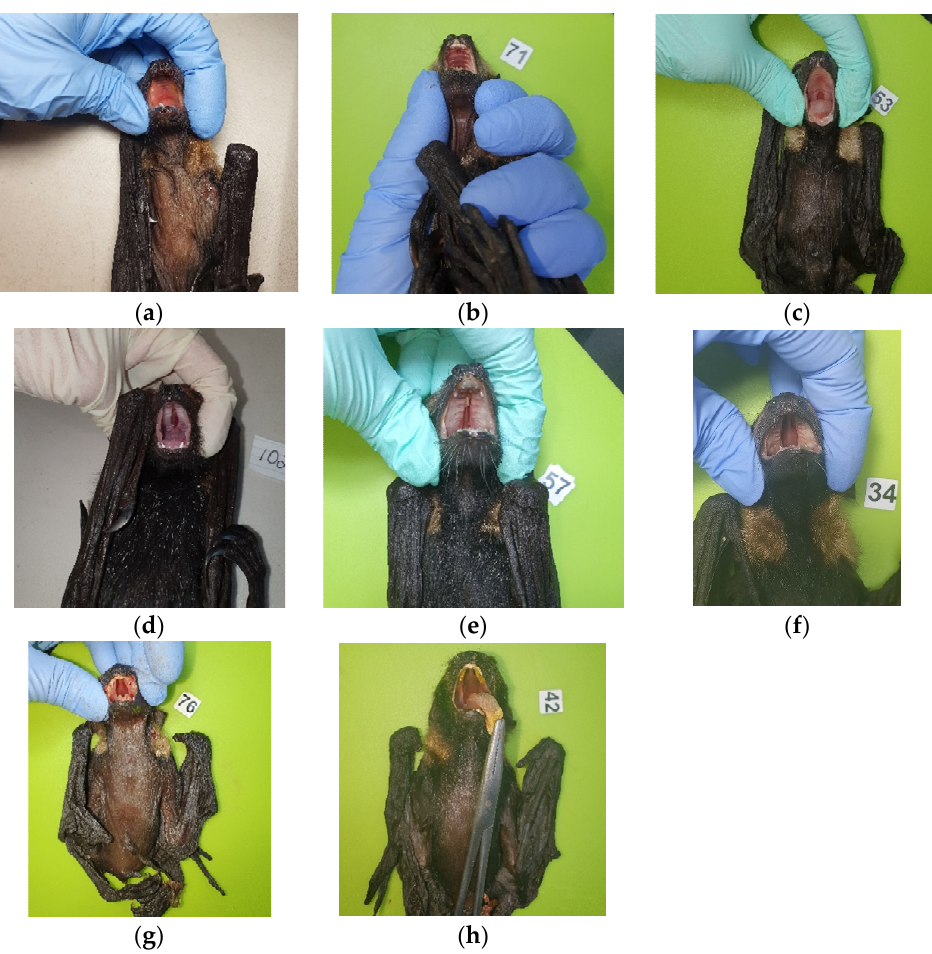
Figure 1. Palate deformities in spectacled flying fox neonates. Normal palate ( a ); minor rostral (anterior) pinhole hard palate cleft ( b ); minor caudal (posterior) soft palate cleft ( c ); midline hard palate fissures ( d – f ); complete hard and soft palate deficits ( g , h ). Upon examination of 27 cleft-palate-affected neonates, palate malformations varied from minor pinhole clefts of either the rostral (anterior) or caudal (posterior) of the palate ( n = 6, 22%), full unilateral midline clefts ( n = 12, 45%), to complete hard and soft palate deficit ( n = 9, 33%). Pinhole clefts ranged between 2 mm and 3 mm in circumference, midline palate clefts ranged in width from 2 mm to 6 mm, while severe clefts where the palate was substantially absent were between 7 mm and 8 mm wide. In 26% of cases ( n = 7), cleft palates were combined with other syndromic signs of wiry facial whiskers, thumb, and feet claw abnormalities. Wiry facial whiskers were associated with 5/9 severe cases where palate was substantially absent, 1/10 cases where animals had full midline clefts, and 1/10 cases of minor pinhole clefts. Missing toe or thumb claws were only associated with 2/9 severe cases, both in addition to wiry facial whiskers. Other syndromic signs observed sporadically over the 20-year period included nare deformities, neurological signs, arthrogryposis, cloudy eyes, and leucism. While these reported clinical signs correspond to historical, potentially subjective, and non-controlled observations, the putative association remains of interest. Histological examination suggests the palatal clefts are ectodermal in nature, demonstrating a complete secondary palatal cleft with minimal outgrowth of palatal shelves (Figure